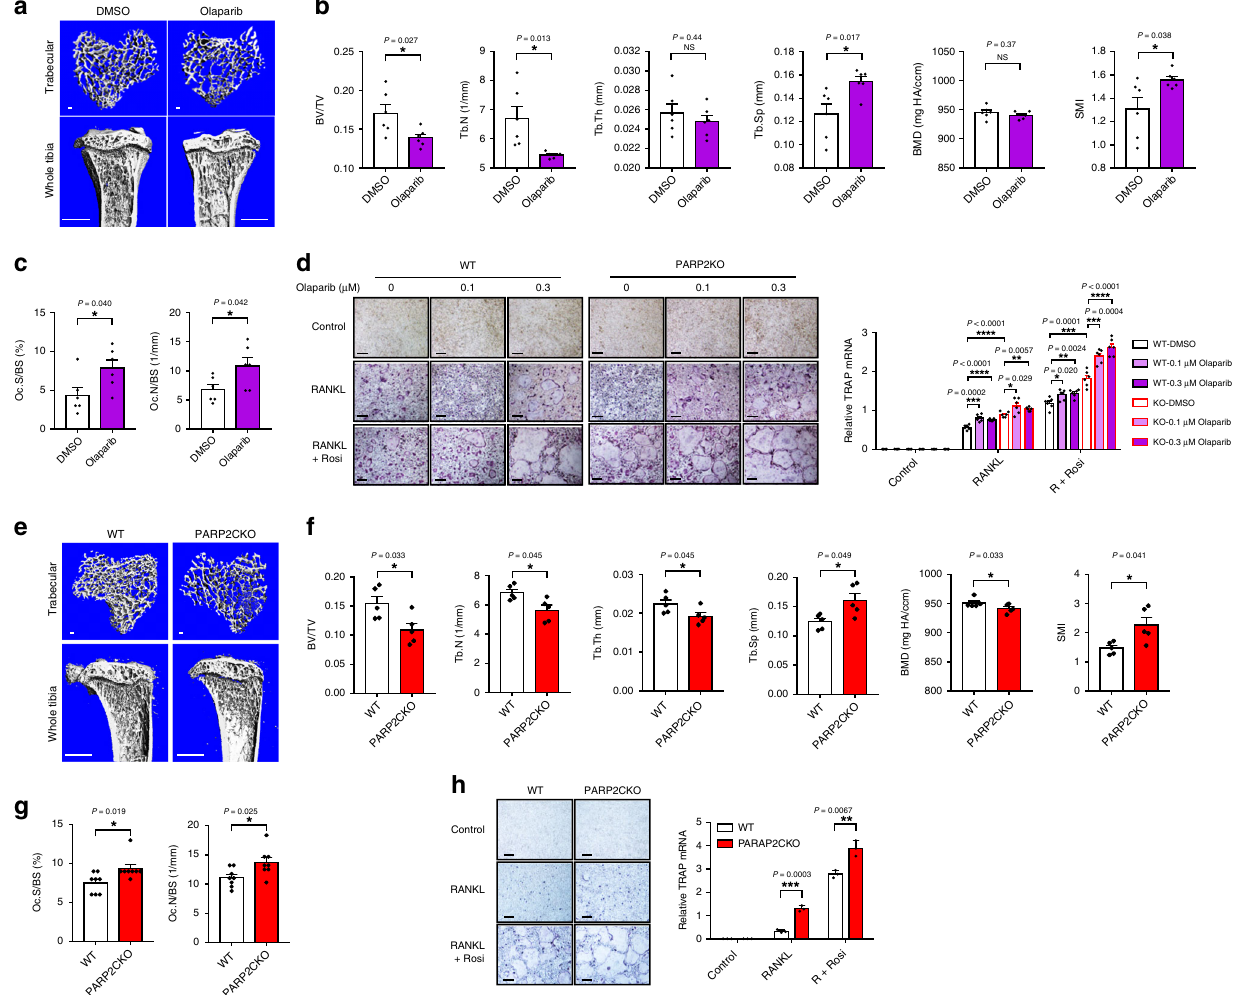
Fig. 2 Olaparib or PARP2 deletion reduces bone mass and promotes osteoclast differentiation. a , b Micro-computed tomography ( μ CT) of the tibiae from B6 mice treated with DMSO or olaparib (2-month-old male, 5-week daily treatment, n = 6). a Images of the trabecular bone of the tibial metaphysis (top; scale bar, 100 μ m) and the entire proximal tibia (bottom; scale bar, 1 mm). b Trabecular bone parameters showed reduced BV, Tb.N, and increased Tb.Sp, SMI of olaparib-treated B6 mice compared with DMSO-treated mice. BV/TV bone volume/tissue volume ratio, Tb.N trabecular number, Tb.Th trabecular thickness, Tb.Sp trabecular separation, BMD bone mineral density, SMI structure model index. c Histomorphometry of TRAP-stained bone sections showed increased osteoclasts in the distal femur from B6 mice treated with olaparib compared with DMSO ( n = 6). Oc.S osteoclast surface, Oc.N osteoclast number. d Treatment with 0.1 or 0.3 μ M olaparib increased in vitro osteoclast differentiation of WT or PARP2KO cultures ( n = 6). Left, TRAP staining (scale bar, 25 μ m); right, TRAP expression. R RANKL, Rosi Rosiglitazone. e , f μ CT of the trabecular bone in tibiae shows that PARP2CKO mice